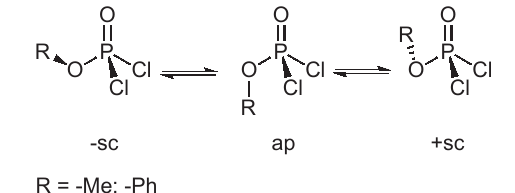
Figure 2. Conformers of methyl and phenyl dichlorophosphates.